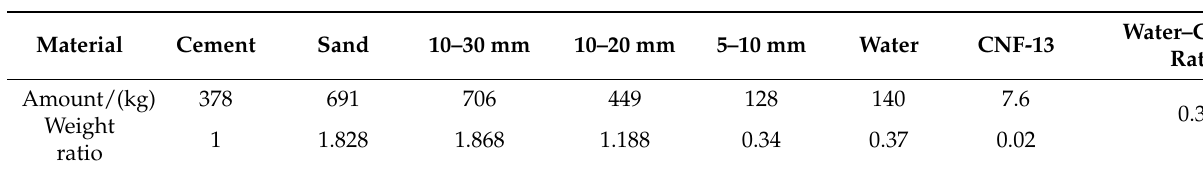
Table 3. Proportion of mix.